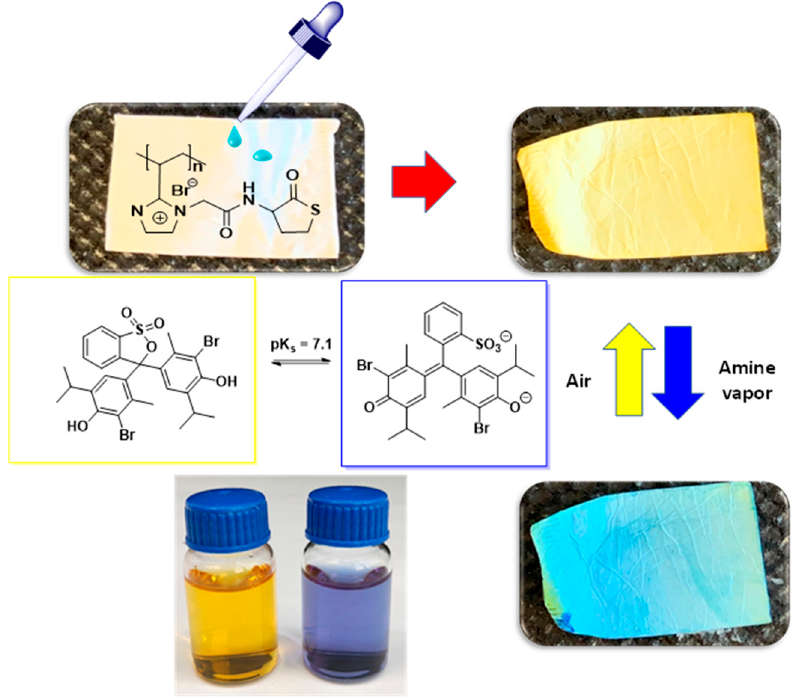
Figure 9. Naked-eye detection of a volatile amine (NH 3 ) using NFm- 6 doped with bromothymol blue (BTB).